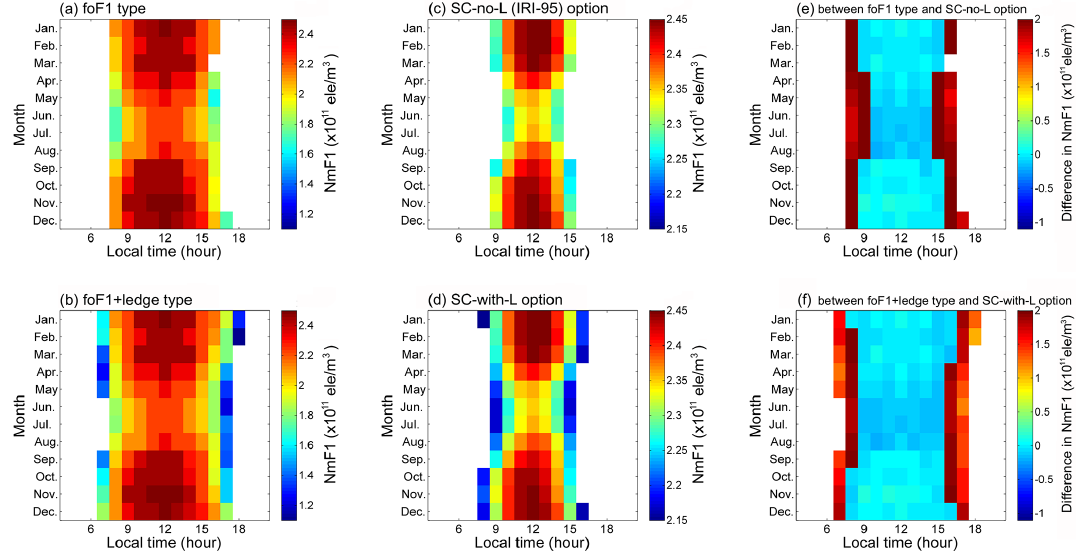
Figure 2. The monthly median Nm F1 values for the (a) fo F1 and (b) fo F1 + ledge types of the Jicamarca digisonde, and for (c) SC-no-L and (d) SC-with-L options of IRI-2012 during January–December 1996. The differences in Nm F1 (e) between fo F1 type and SC-no-L option, and (f) between fo F1 + ledge type and SC-with-L option are